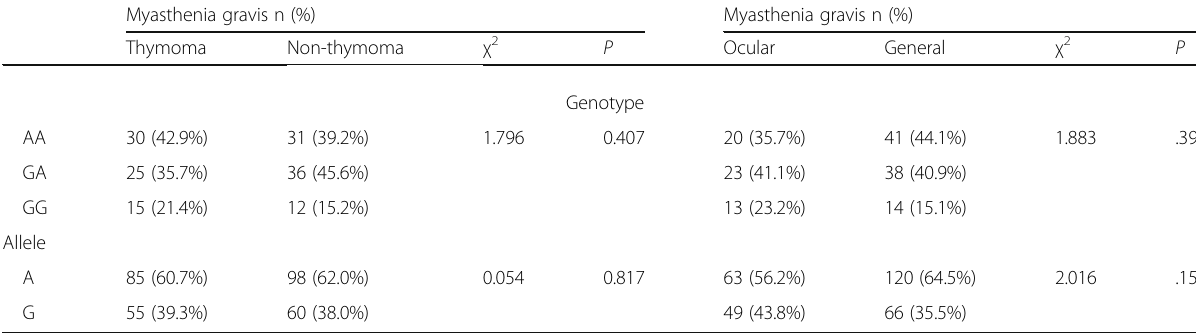
Table 4 Genotype and allele frequencies of BAFF rs2893321 in MG subgroups Myasthenia gravis n (%)